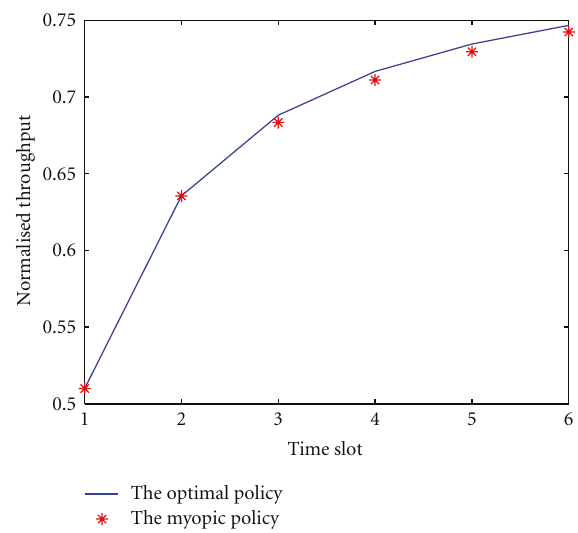
Figure 5: The performance of the myopic policy for nonidentical channels ( N = 5, L = 2, p (1) 01 = [0 . 2 0 . 2 0 . 4 0 . 4 0 . 4], p (2) 01 = [0 . 4 0 . 4 0 . 45 0 . 45 0 . 45], p (1) 11 = [0 . 8 0 . 8 0 . 6 0 . 6 0 . 6], and p (2) 11 = [0 . 7 0 . 7 0 . 5 0 . 5 0 . 5]).